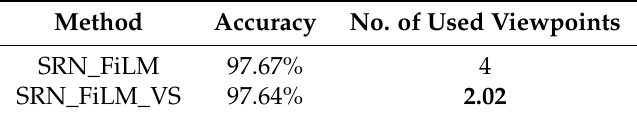
Table 4. Evaluation results for Multi-view-CLEVR_4views_ CG .